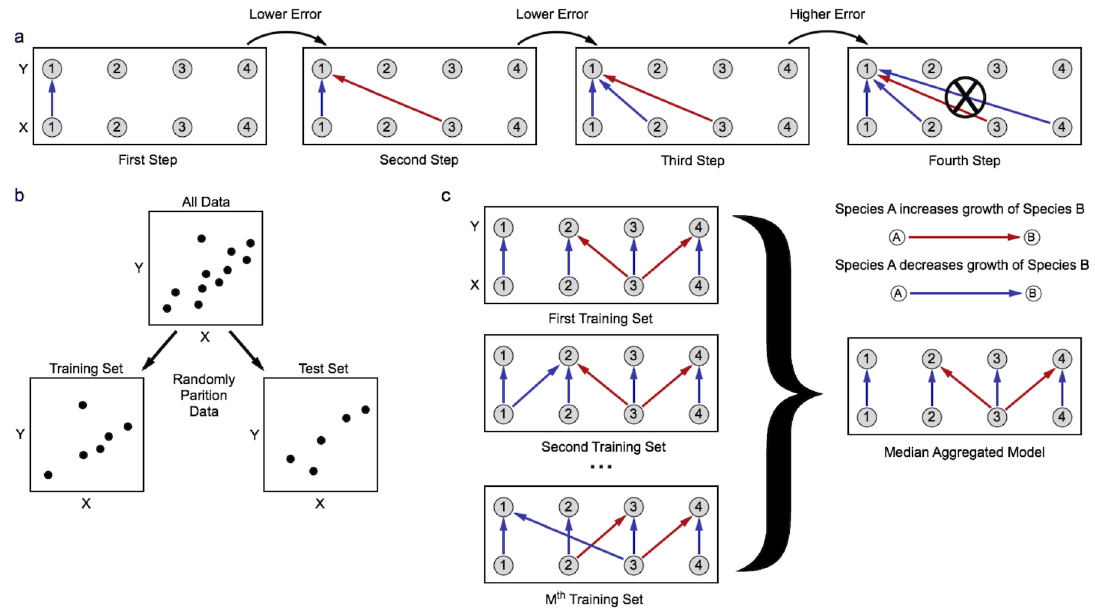
Figure 2. Schematic illustrating forward stepwise regression and median bootstrap aggregating. a) In forward stepwise regression, interactions are added to the model one at a time as long as including the additional covariate lowers the prediction error by a pre-defined threshold. b) The prediction error used for variable selection is evaluated by randomly partitioning the data into a training set used for the regression and a test used to evaluate the prediction error. c) Multiple models are built by repeatedly applying forward stepwise regression to random partitions of the data, each containing half the data points. The models are aggregated, or ‘‘bagged’’, by taking the median, which improves the stability of the fit while preserving the sparsity of the inferred interactions. doi:10.1371/journal.pone.0102451.g002 and Materials and Methods). Note that the average magnetidue of fluke due to a particular choice of interaction matrices, we c ij relative to the noise in these simulations is fixed, and that these calculated the correlation between the true and inferred param- eters for many randomly generated interaction matrices (see Fig. 4 simulations have no measurement errors (see next section for more